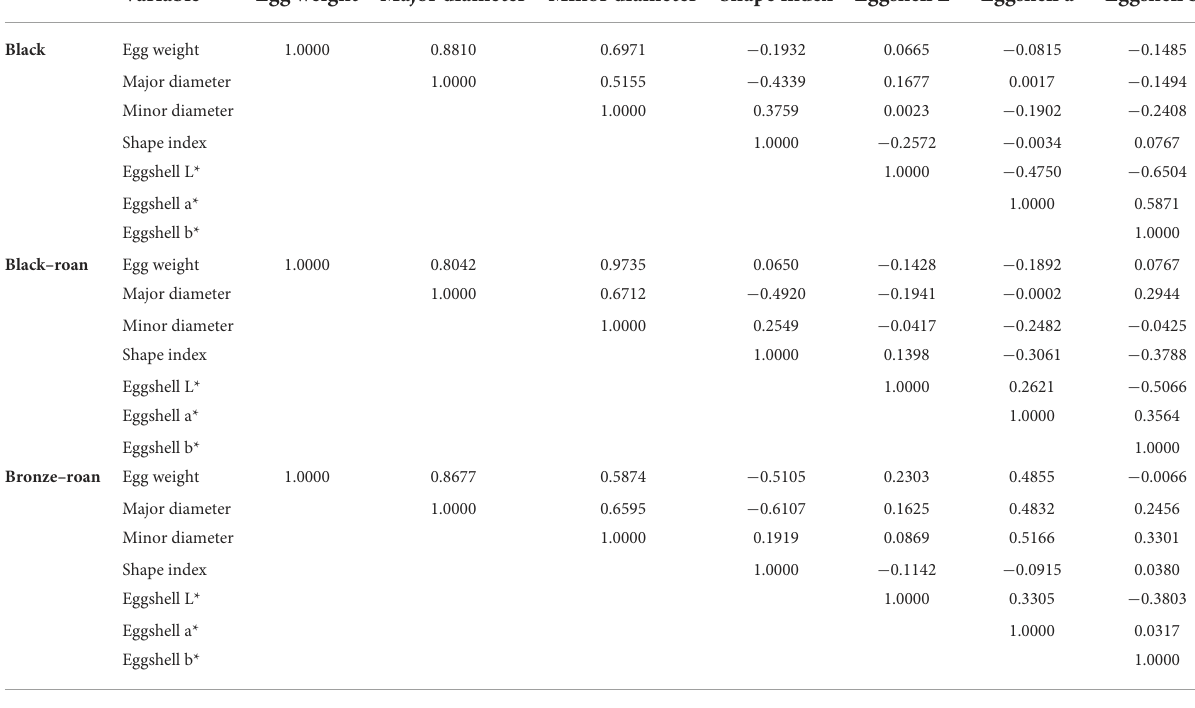
TABLE 1 Correlation matrix for external egg characteristics across Andalusian turkey variety pairs. Variable